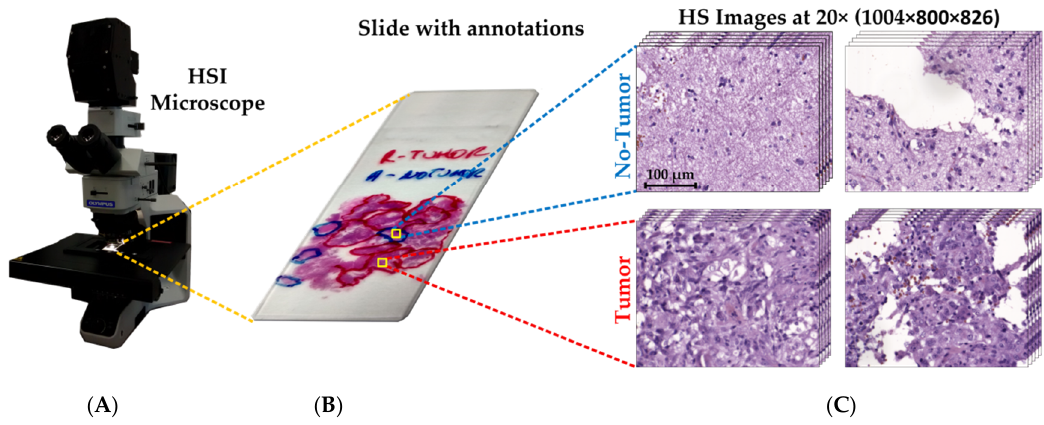
Figure 1. HS data acquisition procedure. ( A ) HS microscope-based acquisition system. ( B ) Pathological slide with macroscopic diagnosis annotations. Yellow squares represent an example of the captured areas for tumor and non-tumor HS images. ( C ) Examples of non-tumor and tumor HS images acquired at 20 ×.